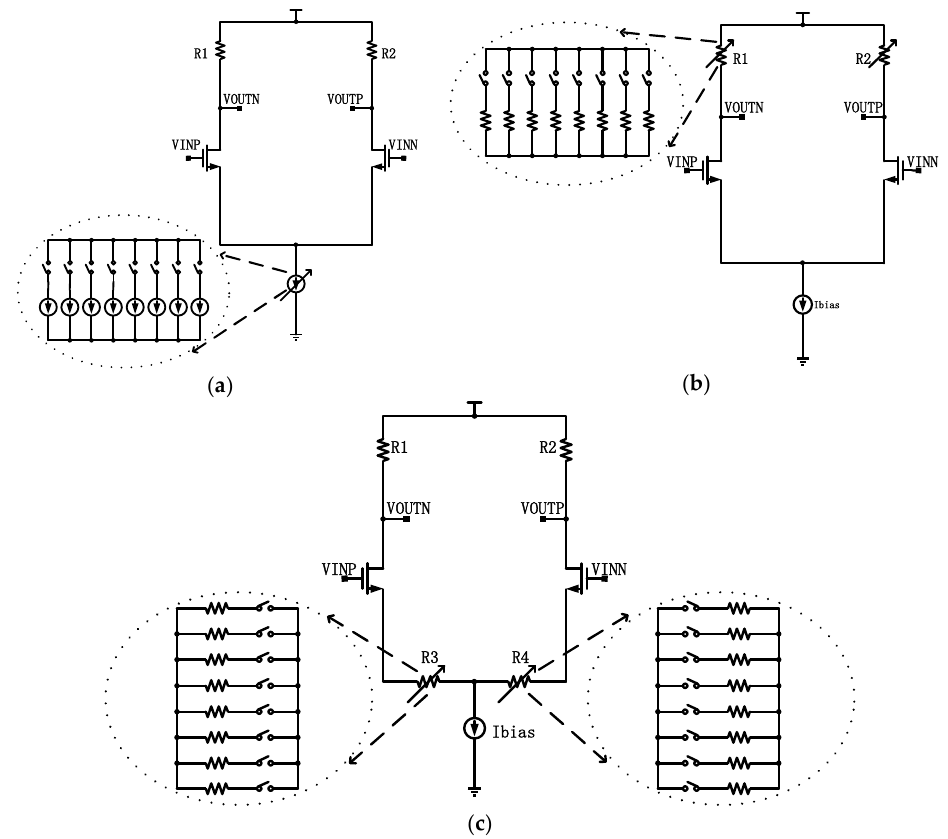
Figure 4. Typical architectures of analog baseband: ( a ) current switching topology; ( b ) load resistor switching topology; ( c ) source degeneration